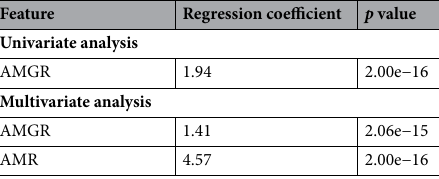
Table 6. Regression coefficient and p -values for regression analysis between AMGR and probability of walking to the right side.